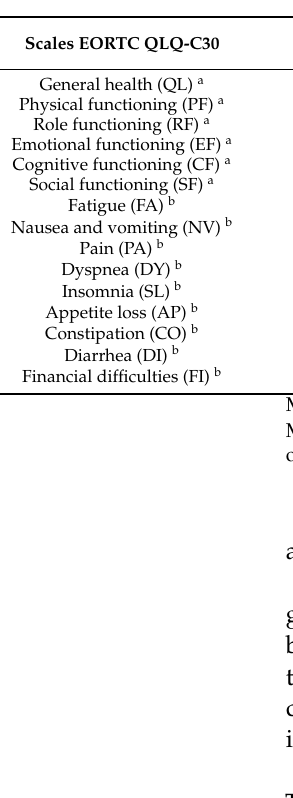
Table 5. Mean score of all items in EORTC QLQ-BR23 of the study group (BCT vs.